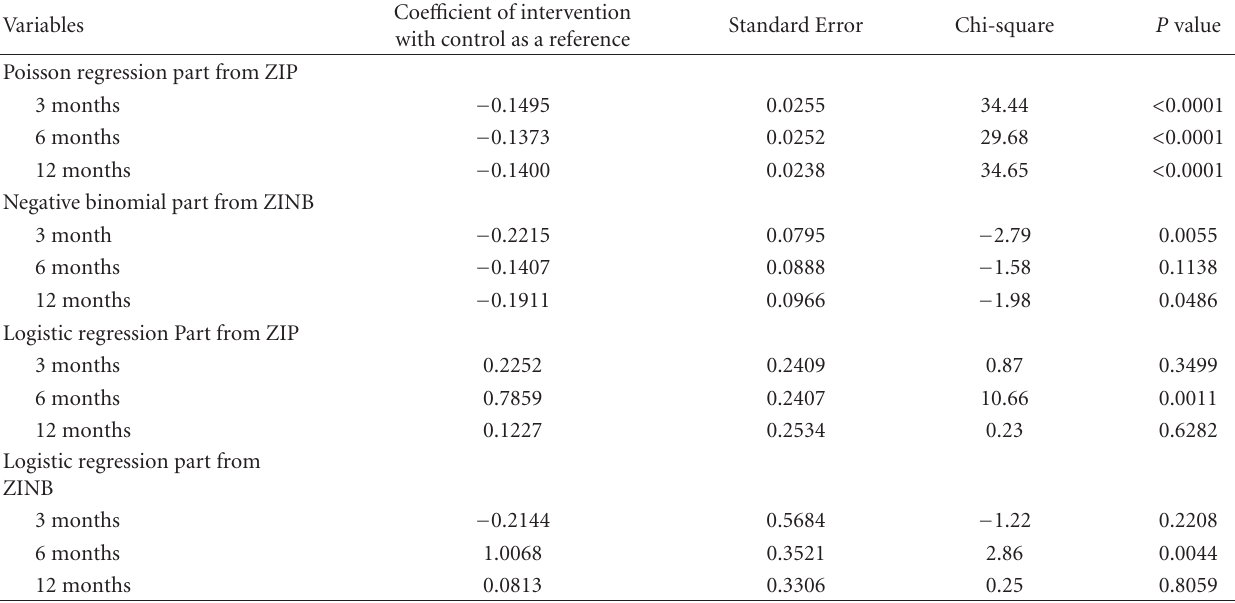
Table 4: Intervention e ff ect for all types of vaginal sex episodes outcome from ZIP and